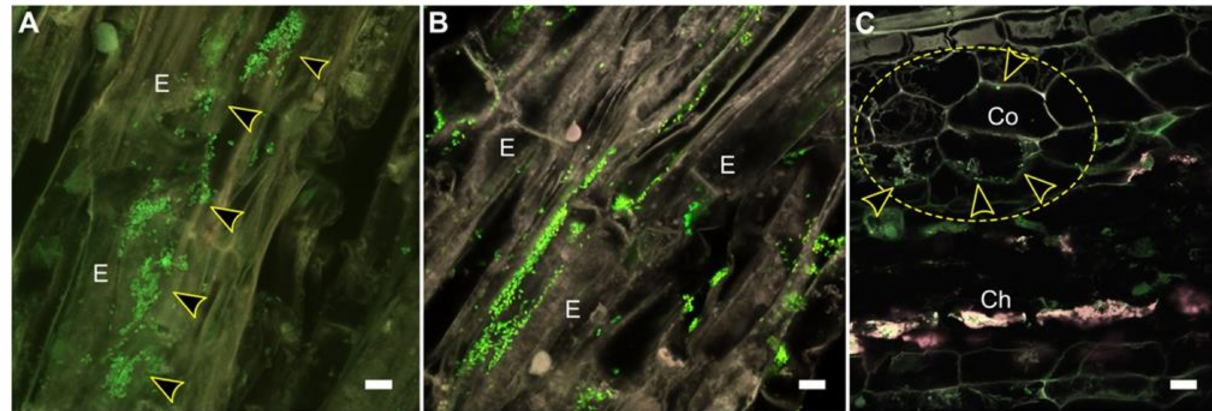
Figure 2. Confocal laser scanning microscopy of Scots pine seedlings colonized by M. extorquens 13060. Bacteria colonizing the pine tissues are carrying a Green Fluorescent Protein (GFP) reporter under a constitutive promoter and visualized in bright green. ( A ) Lateral section of a pine root 30 days post-inoculation (dpi). Arrowheads indicate M. extorquens cells on the root epidermis. ( B ) Individual bacterial cells are visible in the root cortex. ( B ) Lateral section of a pine root 50 dpi where bacteria are colonizing epidermal cells. ( C ) Cross-section of a pine root from a higher region 60 dpi with intracellular bacteria depicted by arrowheads in the cortical cells (circled). Co, cortex; Ch, chlorenchyma; E, epiderm; scale bars, 10 µ